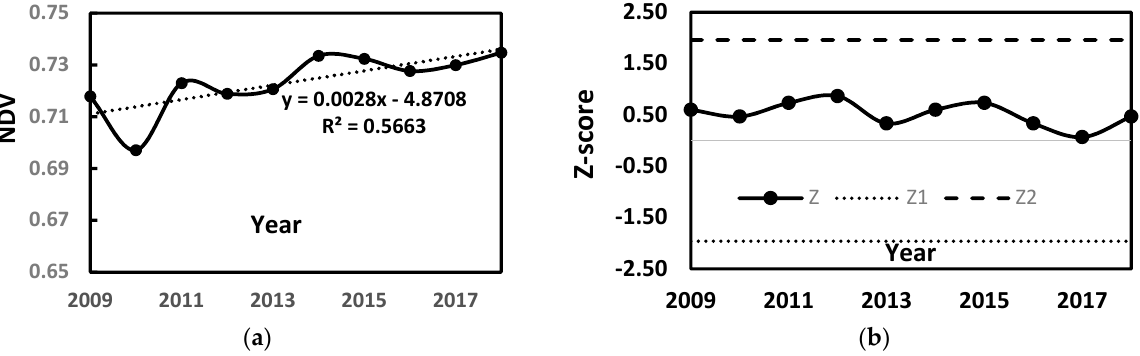
Figure 3. ( a ) Annual variations in growing-season NDVI (Normalized Difference Vegetation Index), ( b ) shows the Mann- Kendall results for trend analysis ( α = 0.05, Z1 = − 1.96, Z2 = 1.96).